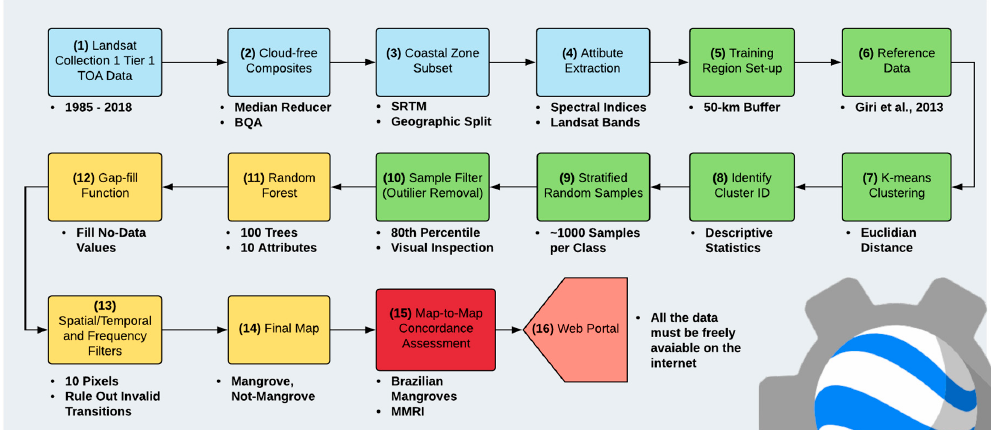
Figure 1. Data-flow diagram. All processing and analysis occur inside the Google Earth Engine (GEE) platform. Steps related to image processing are in blue. The steps in green are related to the sample design. Classification procedures are in yellow. The concordance assessment phase is in red and, finally, the data availability is in salmon. BQA and SRTM denotes Band Quality Assessment and Shuttle Radar Topography Mission, respectively.